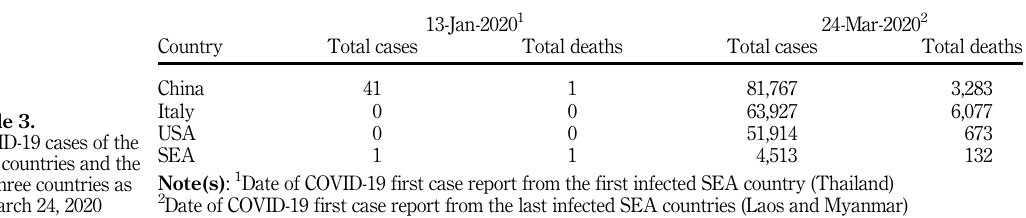
Table 3. COVID-19 cases of the SEA countries and the top three countries